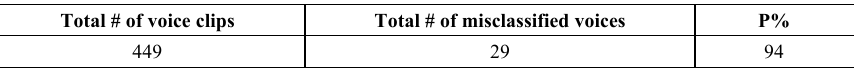
Table 1. Precision (P%) Precision: The number of female and male voice correctly detected / total number of female and male voices.